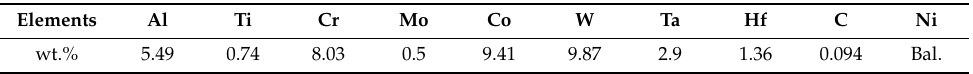
Table 5. The composition of superalloy CM247LC /